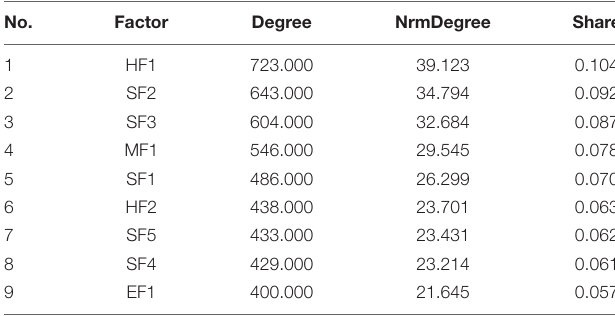
TABLE 5 | Point centrality score of influencing factors of construction workers’ unsafe behavior.